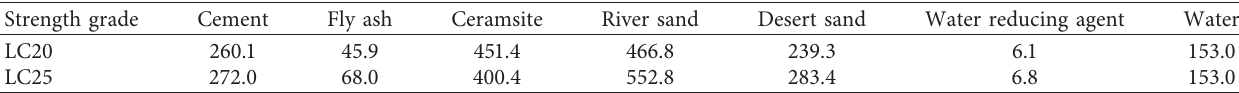
Figure 3: Curves of relationship between desert sand substitution rate and performance of desert sand ceramsite concrete. (a) Trend curve of slump. (b) Trend curve of 28days’ natural apparent density. (c) Trend curve of 7 and 28days’ tube crushing strength. Table 12: Benchmark mixture ratio of desert sand ceramsite lightweight aggregate concrete. Strength grade